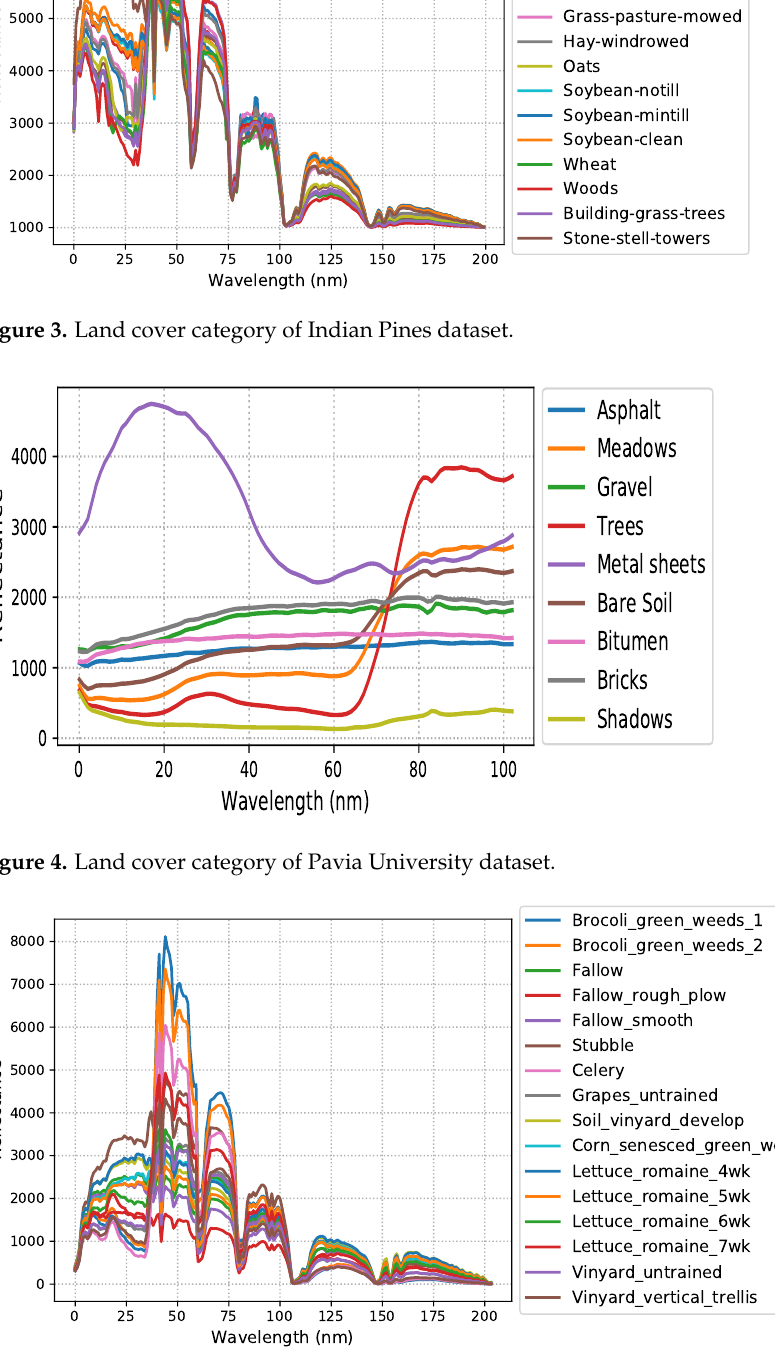
Figure 5. Land cover category of Salinas Scene